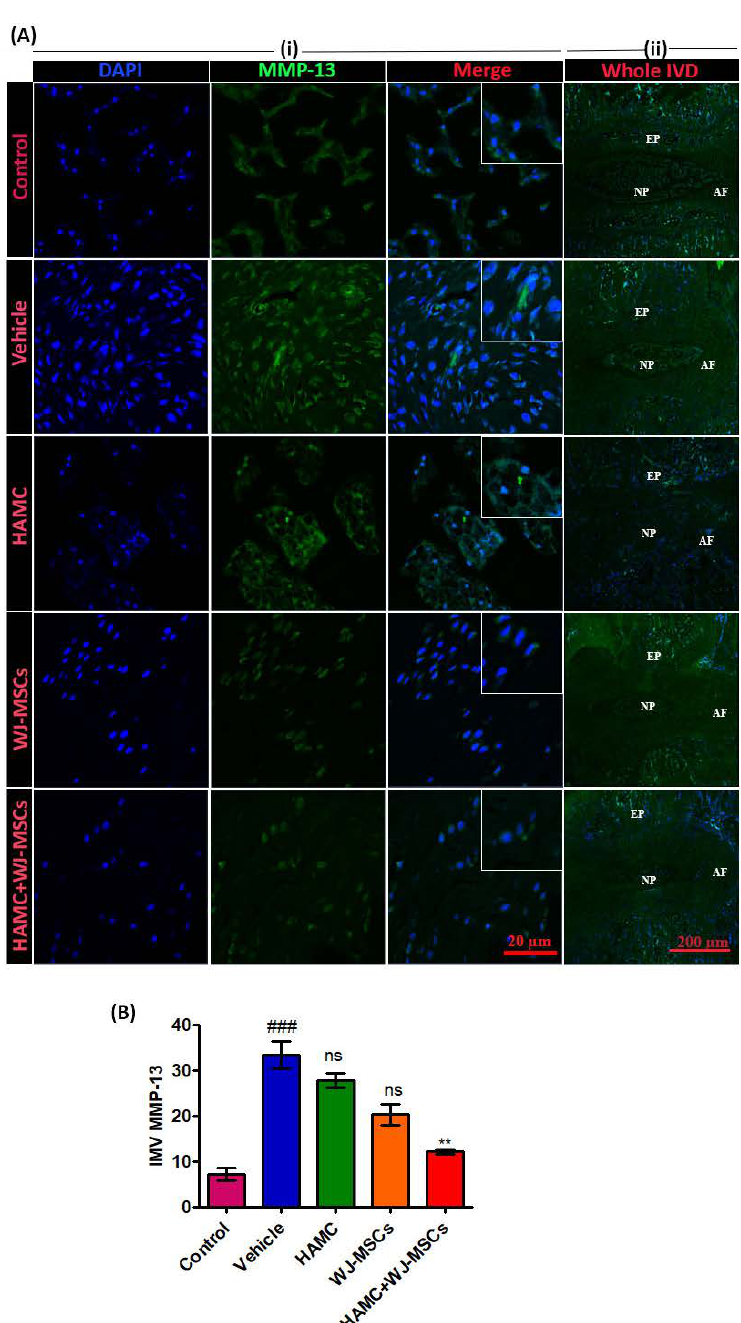
Figure 5. Combined injection of HAMC and WJ-MSC substantially reduced matrix metalloproteinase-13 (MMP-13) expression in degenerated disc. ( A ) Representative MMP-13 protein levels as determined by immunofluorescence staining. (i) MMP-13 expression (green) at region of interest (ROI), DAPI (blue) and merge signal (ii) full power images (far right panel) demarcating entire disc (nucleus pulposus—NP, annulus fibrosus—AF and end plate—EP), and MMP-13 expression in whole NP area. ( B ) Quantitative immunofluorescence intensity for MMP-13 expression. Immunopositivity was counted in at least three random low power fields ( × 40) and calculated as mean intensity. Mean ± SEM, ( n = 3), one-way ANOVA followed by Tukey’s post-test. ### p < 0.001 (vehicle vs. control), ** p < 0.01 (HAMC + WJ-MSCs vs. WJ-MSCs). Ns = non-significant. We found that combined injection of HAMC and WJ-MSC significantly diminished the expression of matrix-degrading enzyme,